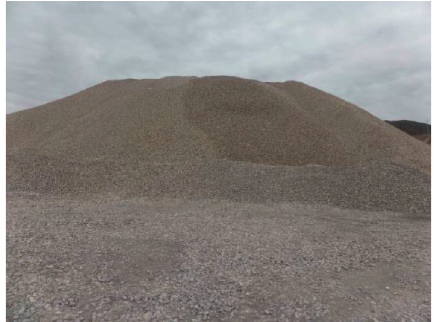
Figure 2: Waste rock